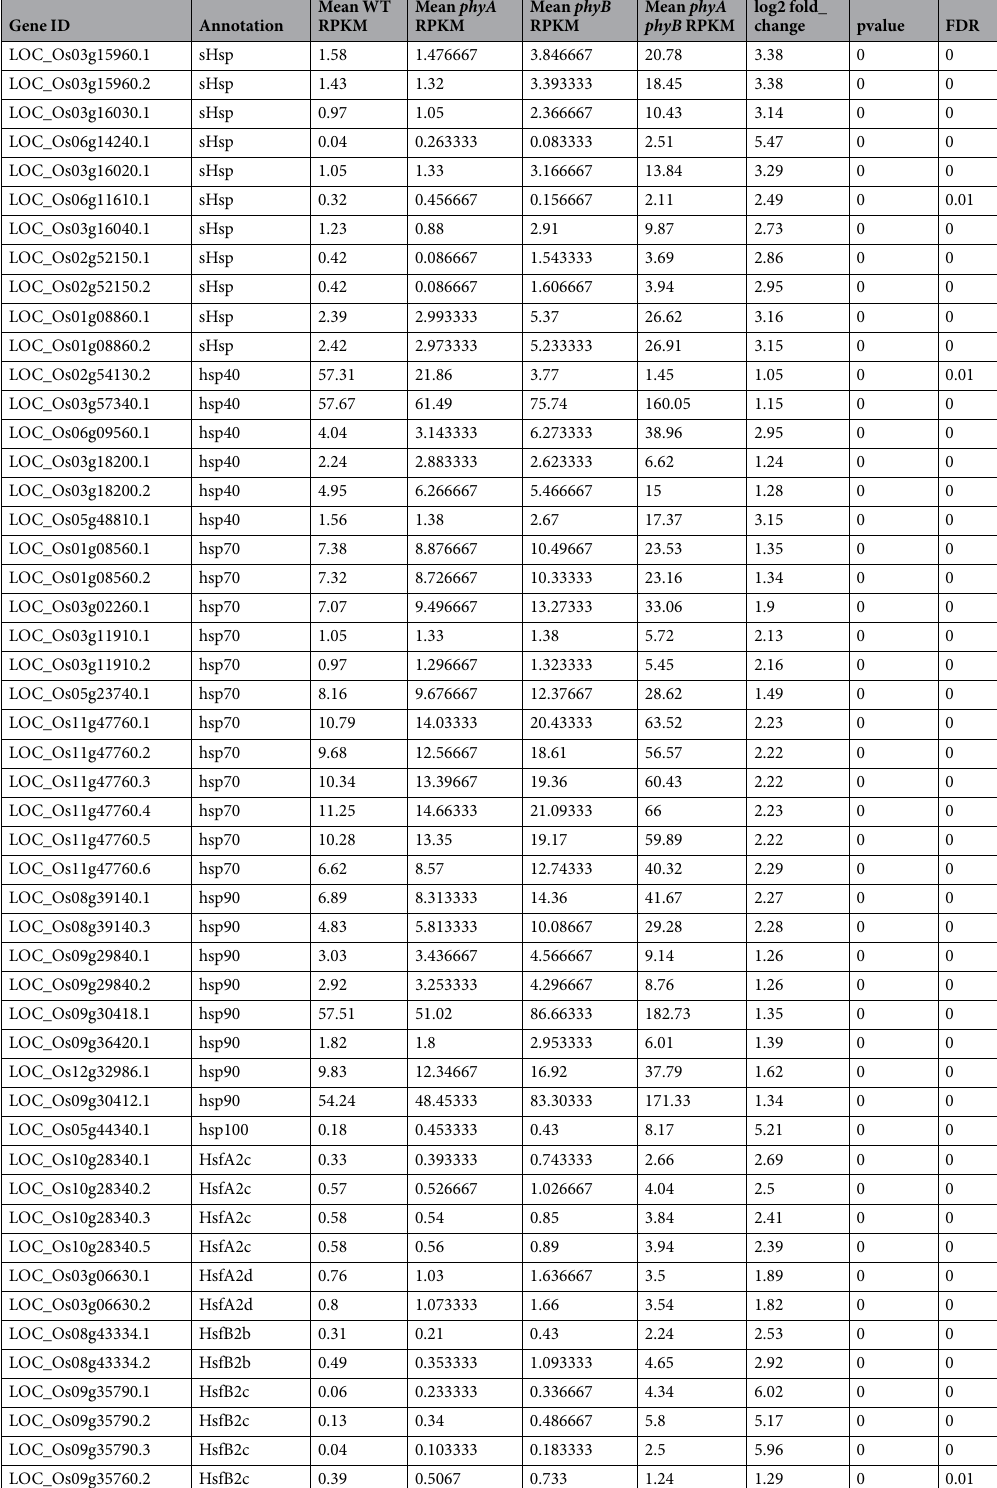
Table 2. Heat-shock proteins and heat-shock factors up-regulated in the phyA phyB